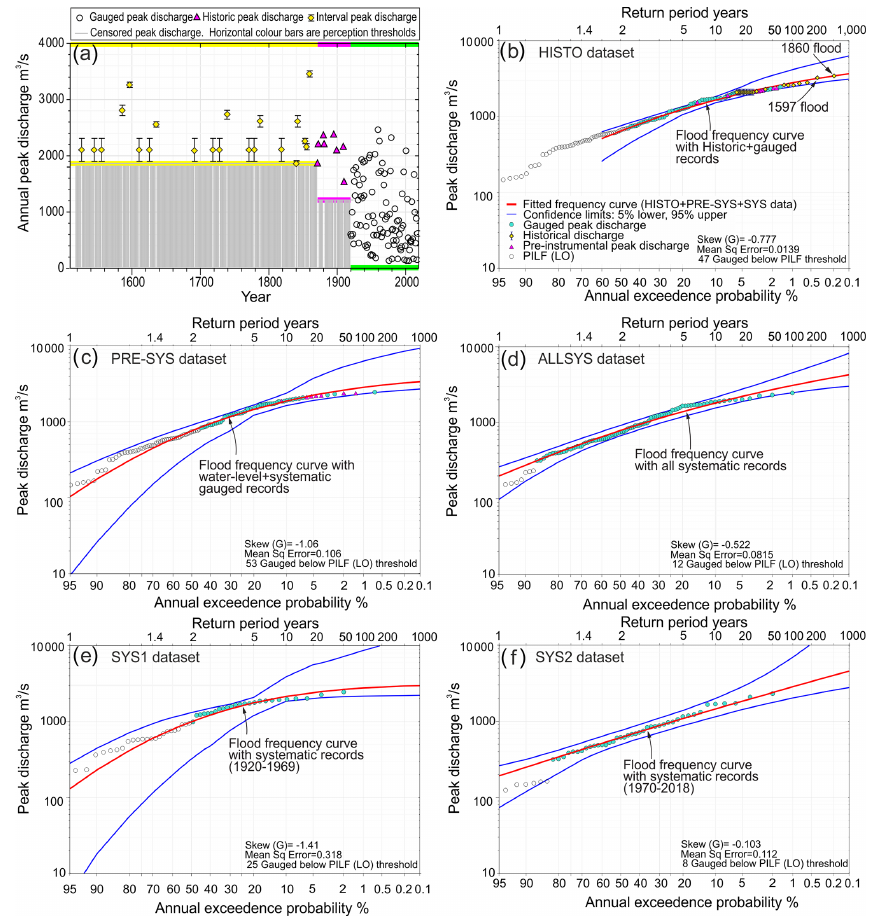
Figure 11. (a) Temporal representation of documentary and gauged floods. Grey shaded areas indicate censored flood records during the pre-instrumental period. The coloured horizontal lines are perception thresholds over different time periods; i.e. only floods exceeding the perception threshold discharge were recorded. The yellow diamond dots show discharges for documentary floods including a range of discharge uncertainty (vertical lines). The pink triangles are reported discharge from staff gauge observations at El Porvenir. The white dots are annual flows from the Carrascal gauge station. (b) Log Pearson type III distribution fitted with historic flood events and gauged discharge (staff and continuous gauged). (c) Idem fitted with staff and continuous gauge records. (d) Idem with all continuous gauge records. (e) Idem with gauged records over the period 1920–1969. (f) Idem with gauged discharges over the period